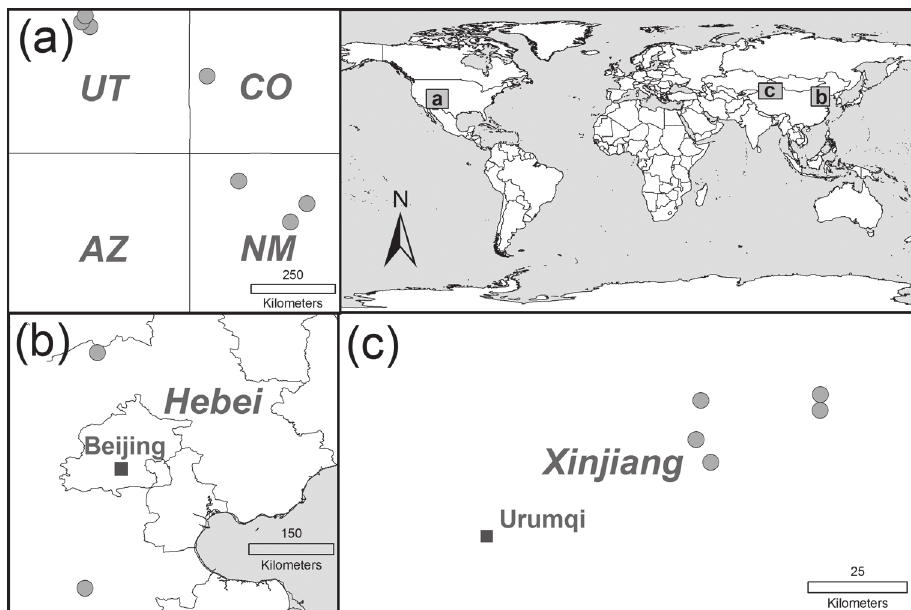
Figure 1. Sampled Ulmus pumila populations in the native range ( b, c ) and the non-native range (U.S.: a ; AZ = Arizona, CO = Colorado, NM = New Mexico, UT = Utah). Populations are indicated by gray